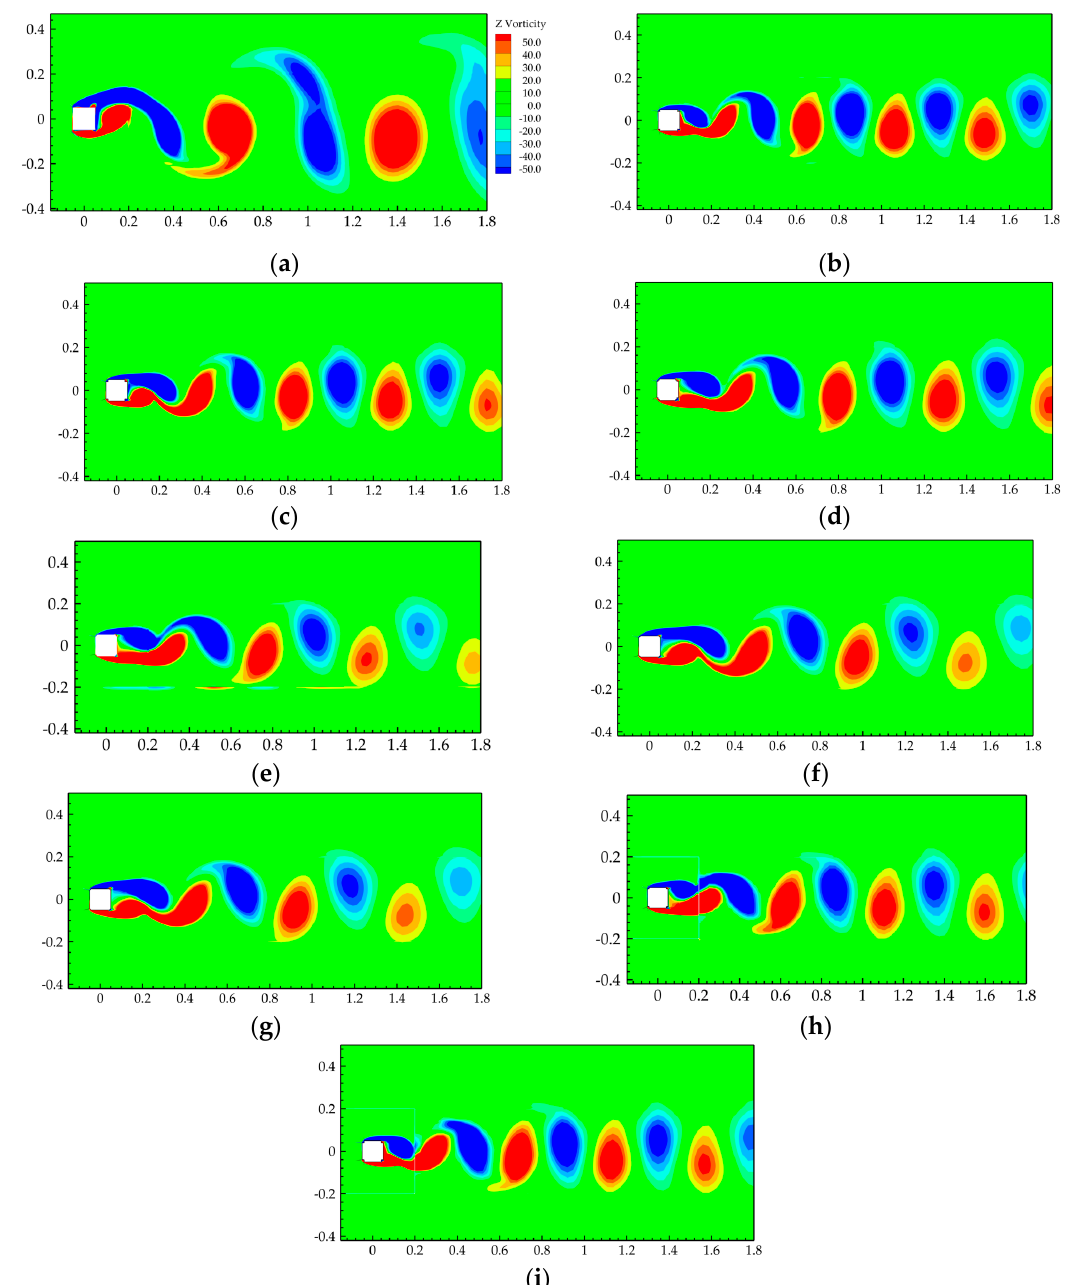
Figure 12. Instantaneous vorticity contours around different sections: ( a ) S and ( b – i ) M1~M8.